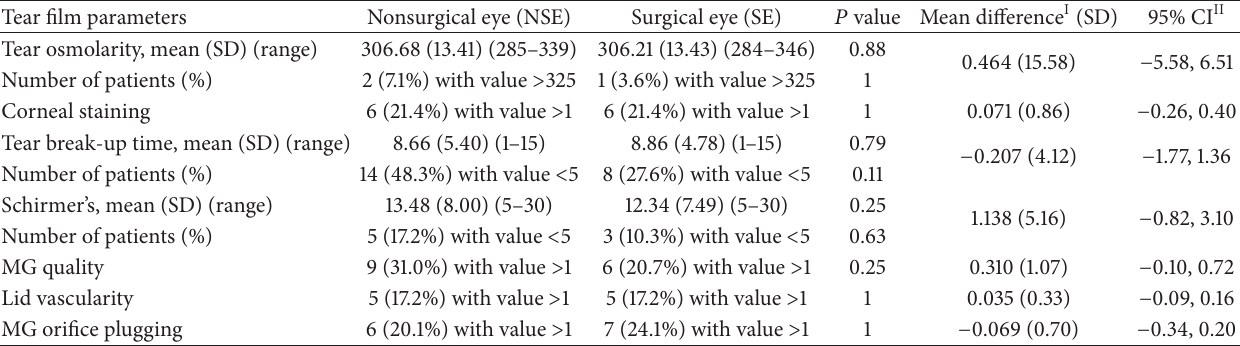
Table 2: Tear film parameters of the study population comparing non-surgical eye to surgical